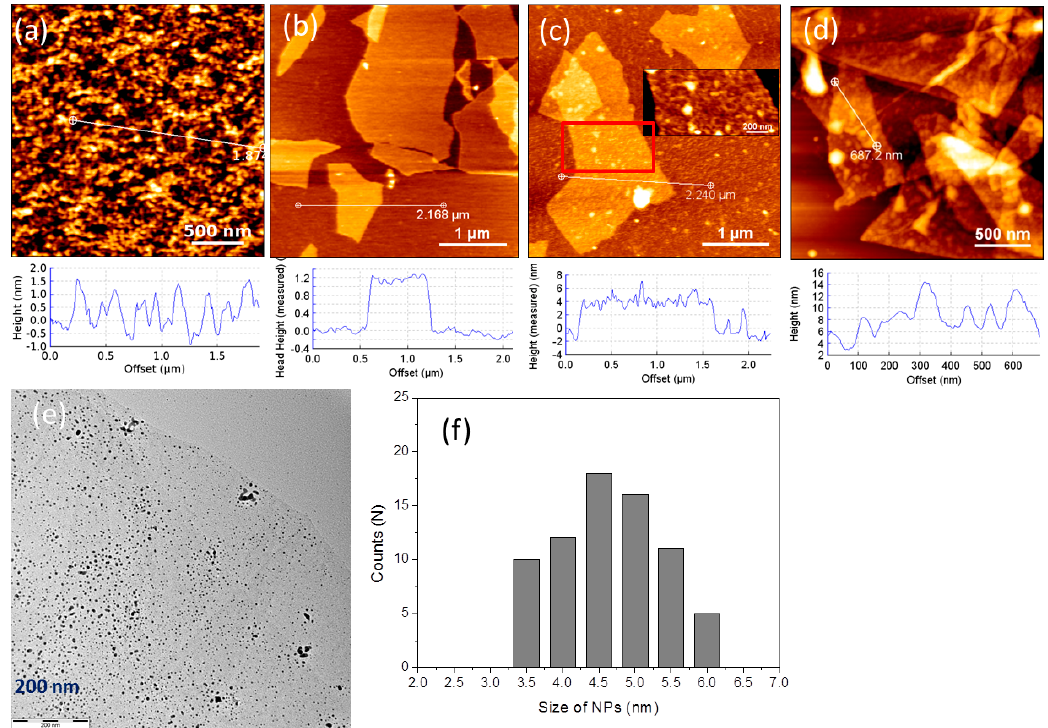
Figure 2. Morphological characterizations of materials: ( a – d ) AFM characterization of ( a ) peptide; ( b ) GO; ( c ) GO–peptide, the inset is the zoomed area of the red box; and ( d ) GO–peptide–AgNPs; ( e ) TEM image of AgNPs formed on the GO surface; ( f ) corresponding statistical analysis of the size of nanoparticles in ( e ).